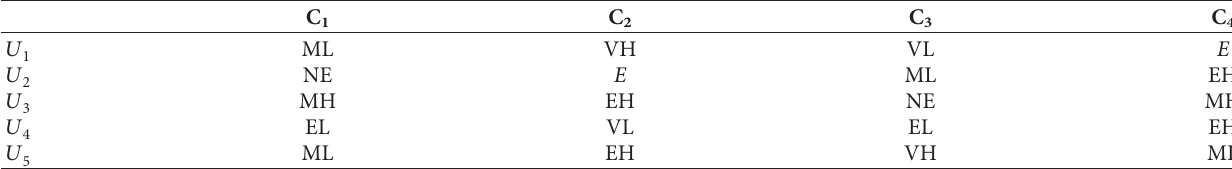
Table 3: The evaluated linguistic values of decision maker DM